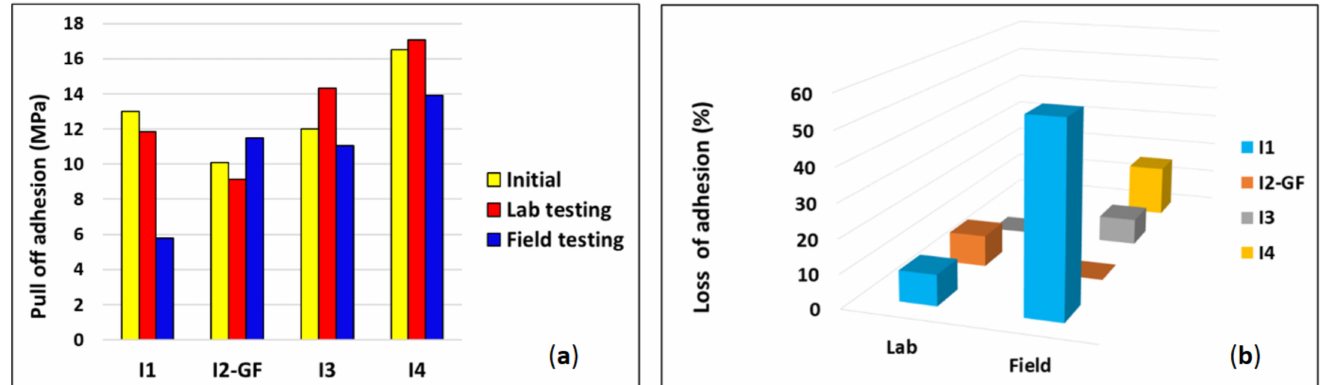
Figure 9. ( a ) Pull-off adhesion strength of the coatings for the submerged zone before and after laboratory aging and field exposure. ( b ) Loss of adhesion of the coating systems after aging and field exposure.